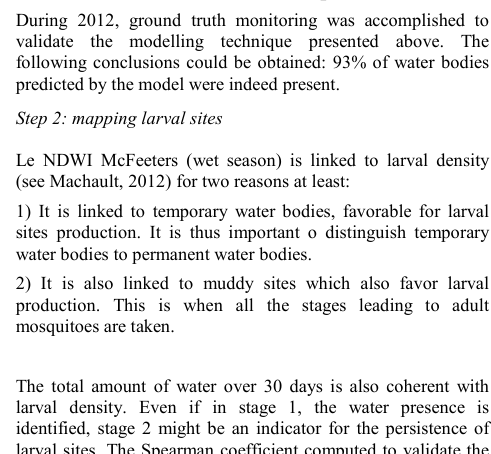
Figure 4 : Results for the prediction of water bodies (in blue and for step1)